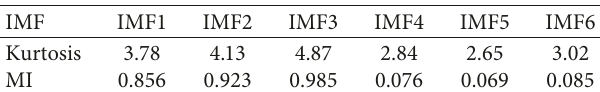
Figure 20: Waveform and spectrum of IMFs by VMD for rolling. Table 3: The kurtosis values and mutual information (MI) of IMFs for real signal with rising speed.